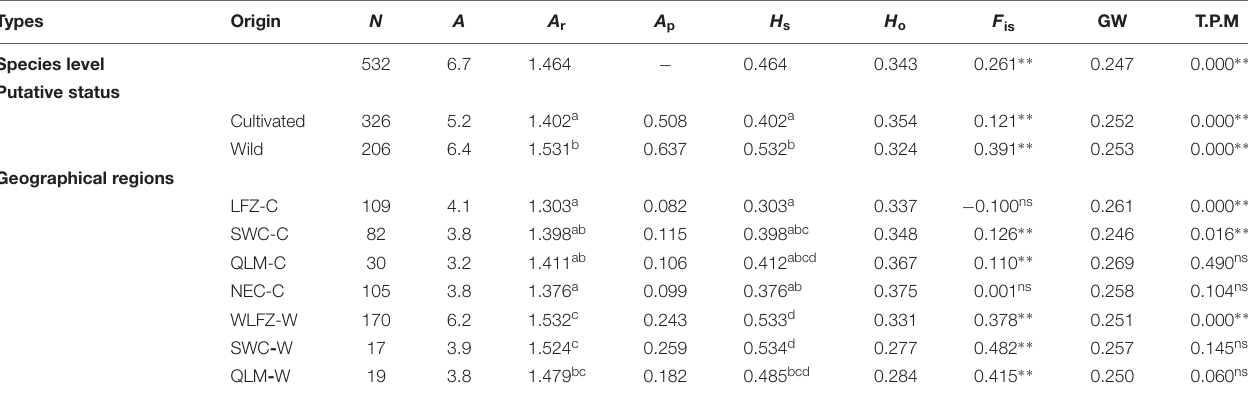
TABLE 1 | The genetic diversity, inbreeding coefficients, Garza–Williamson index and T.P.M values in Chinese